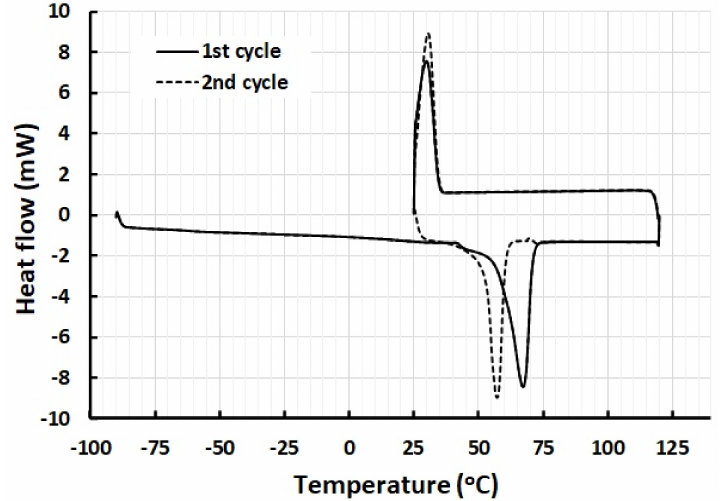
Figure 3. DSC result of PCL in two thermal